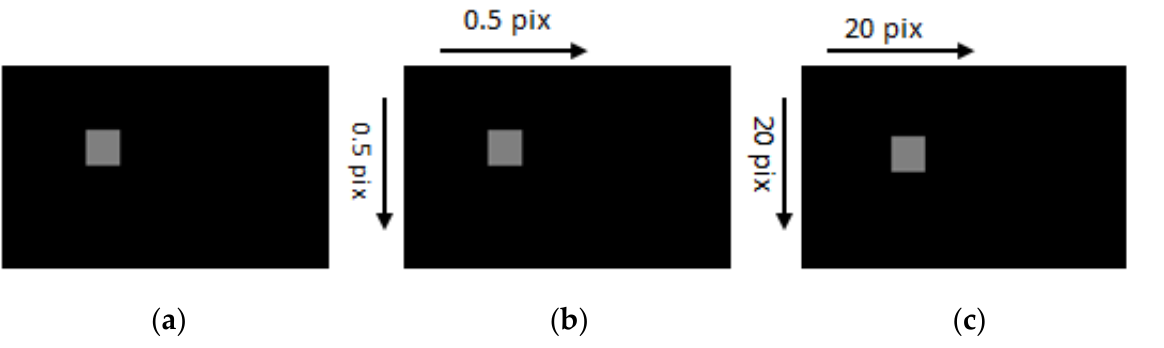
Figure 2. Patch test. ( a ) Original patch. ( b ) Patch shifted by 0.5 pix in both directions. ( c ) Patch shifted by 20 pix in both directions. Table 2. Results of validation tests of the optical flow algorithms. Test Method